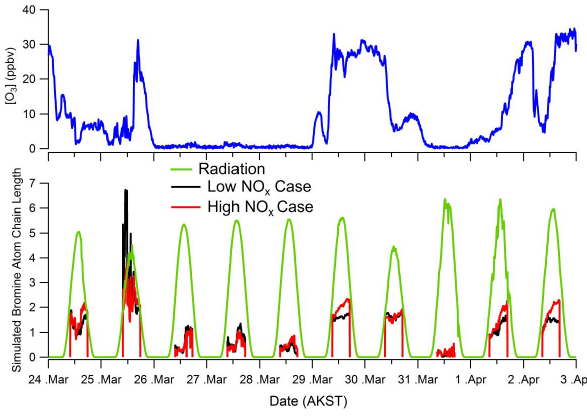
Figure 3. Calculated bromine chain length for the low NO x sim- ulation and the high NO x simulation along with observed O 3 and